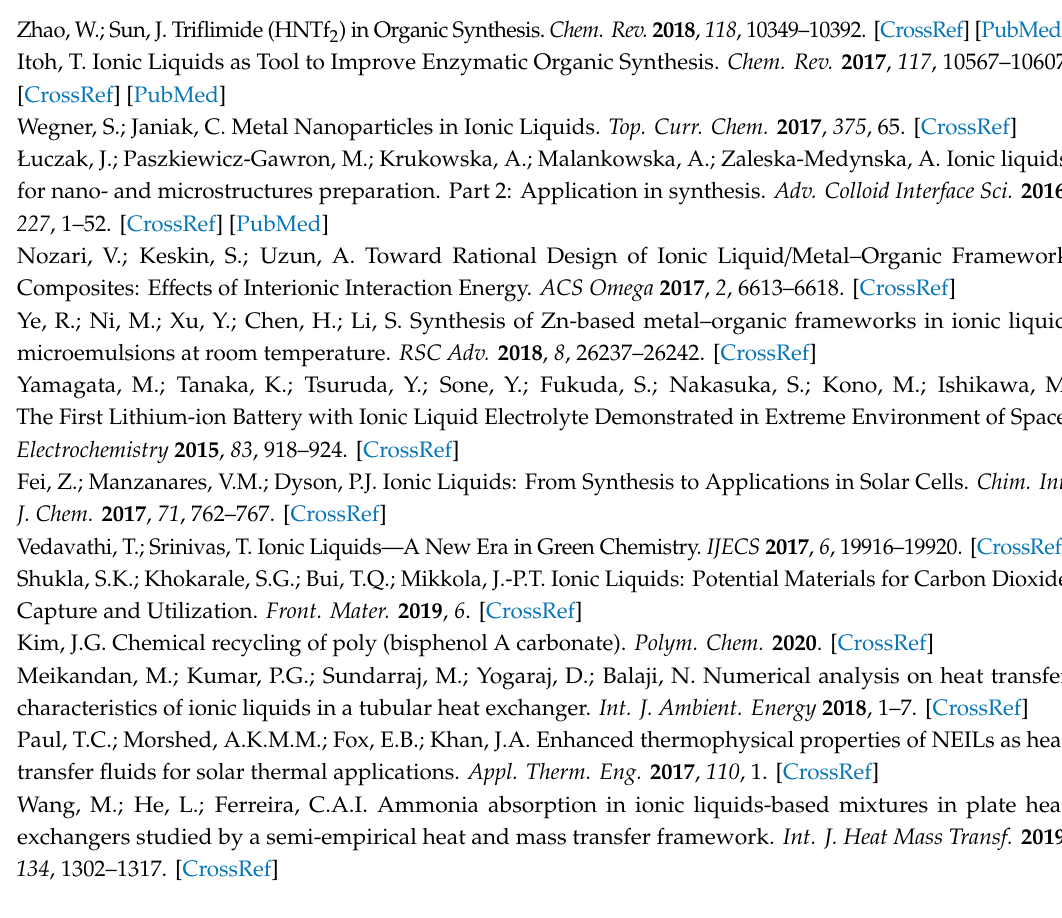
Supplementary Materials: The following are available online. General method for the synthesis of symmetric disiloxane dicationic ILs 1, 2, 4, 5, 10 and 11; Synthesis of 1-(2-methoxyethyl)-2-methylimidazole; Experimental data of ILs with an asymmetric